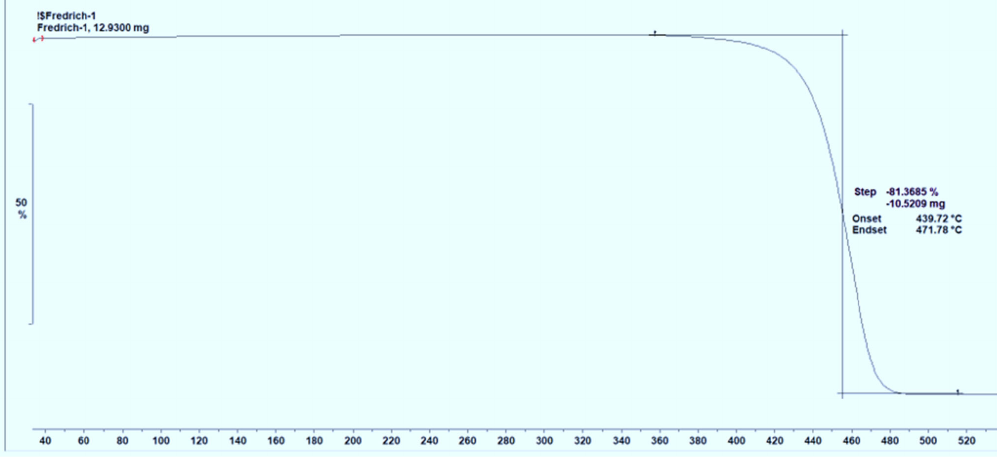
Figure A3. TGA curve for the fresh powder material.